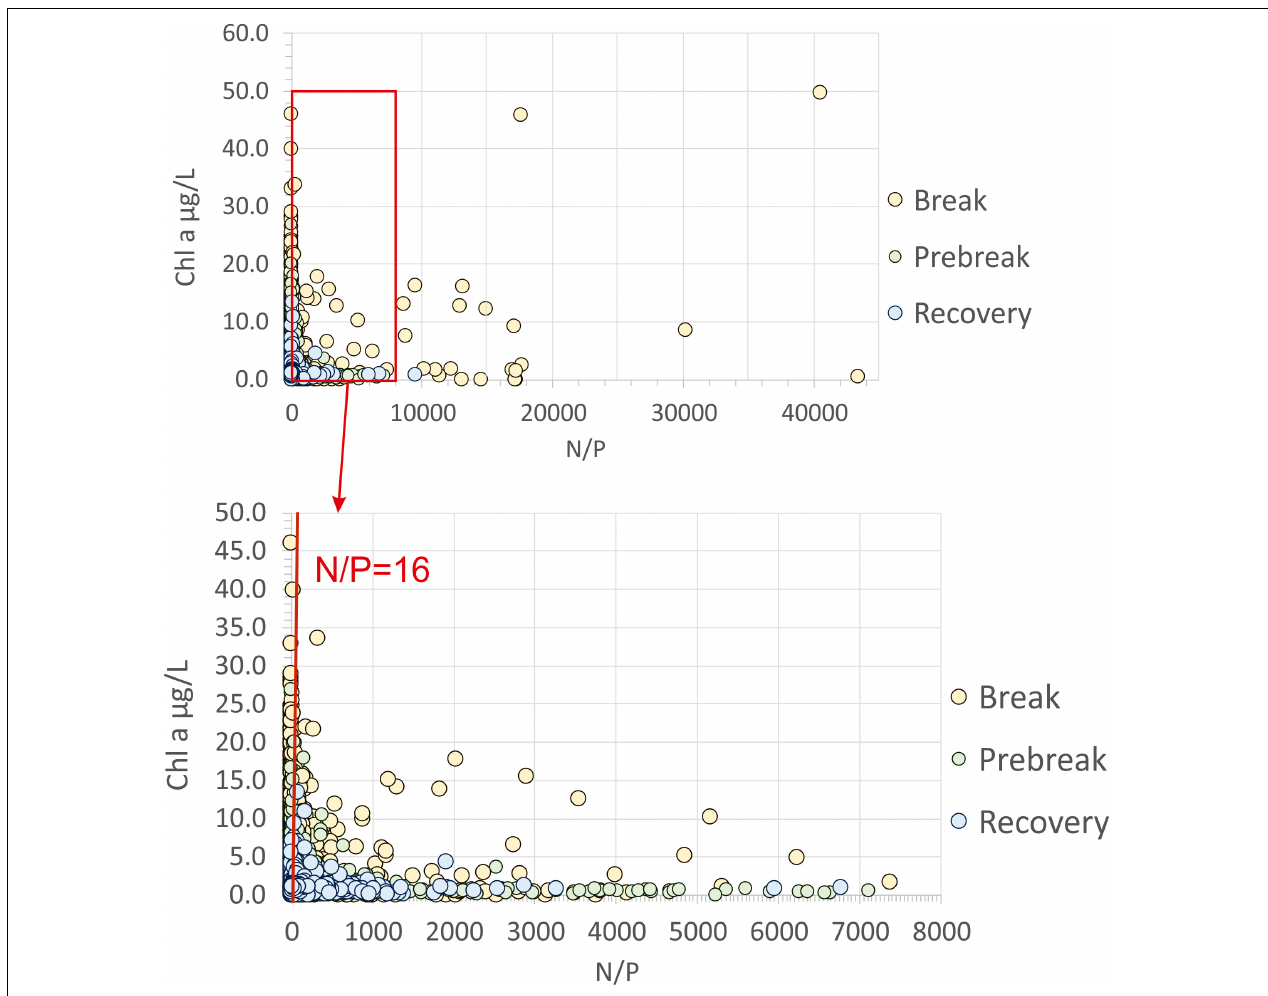
FIGURE 11 | Distribution of chlorophyll a concentration data against N/P ratio values in the Mar Menor lagoon during the three phases of the eutrophication process (1997–2018). There is no significant